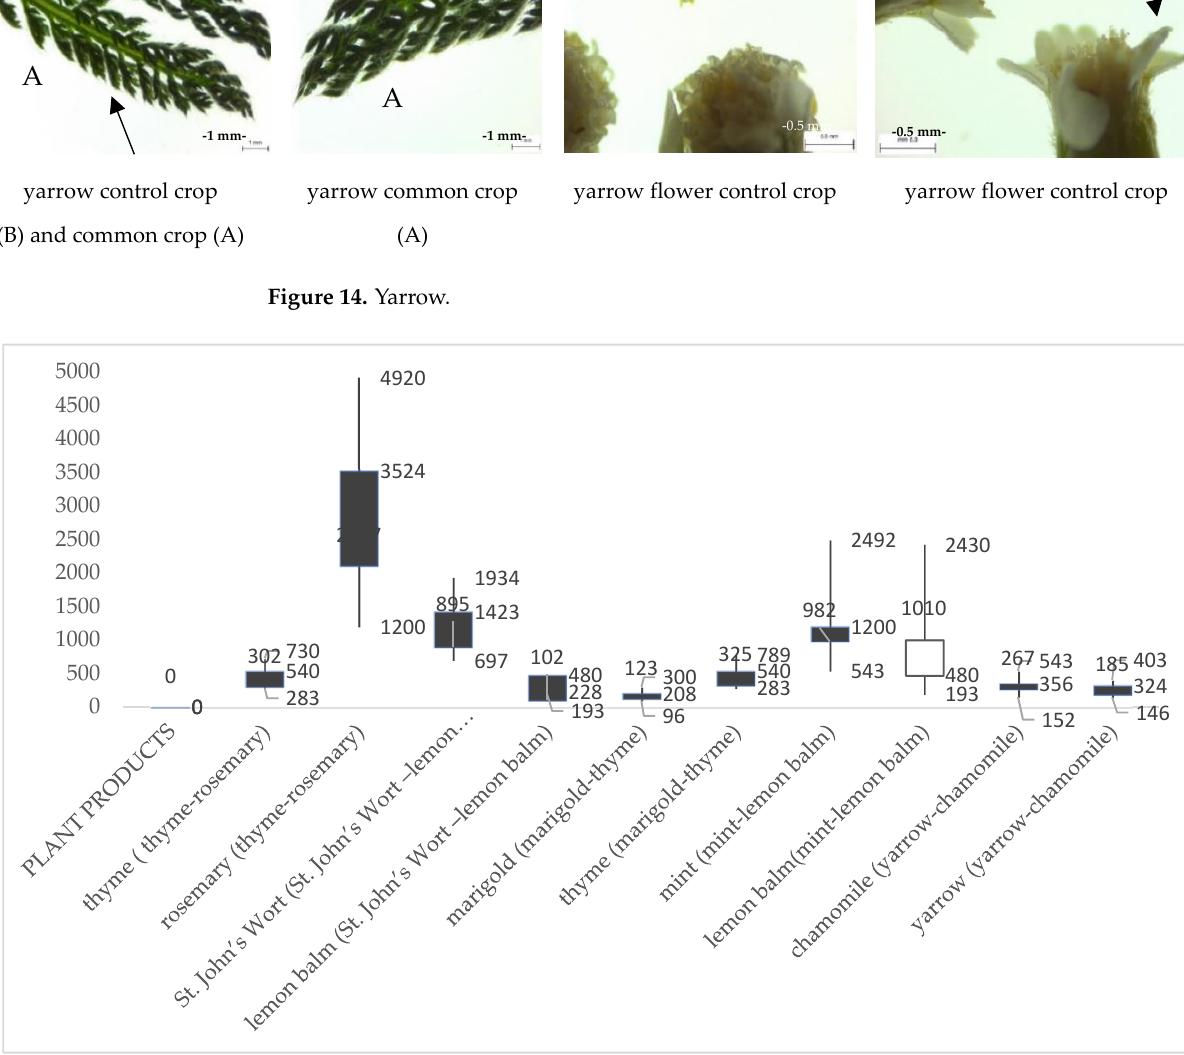
Figure 15. Graphic representation of vegetable products’ mass in 2020. Table 3. Representation of vegetable products’ mass in 2020.